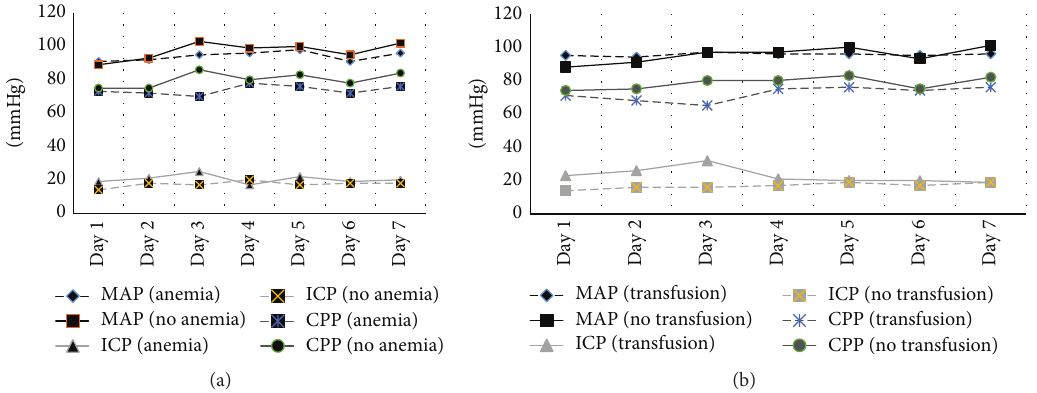
Figure 2: Mean arterial pressure (MAP), intracranial pressure (ICP) and cerebral perfusion pressure (CPP) in the first 7 days of stay in the intensive care unit. (a) Pressure values in patients who developed anemia (hemoglobin < 10 g/dL) and those who did not. (b) Pressure values in patients who received blood transfusion and those who did not. 𝑝 values between groups were > 0.05 for all points except for MAP on day 1 for transfused versus nontransfused patients ( 𝑝 = 0.04